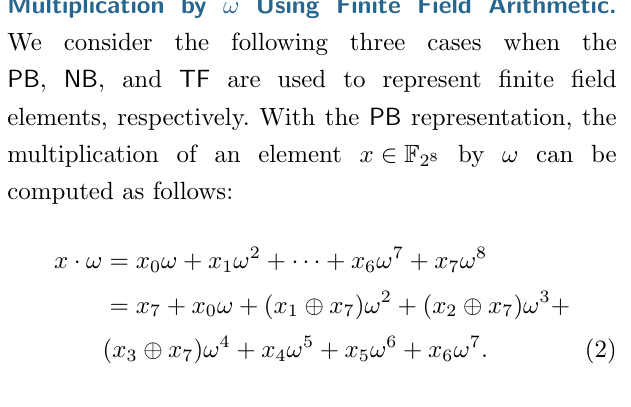
Table 1. The Cosets and Coset Leaders of F